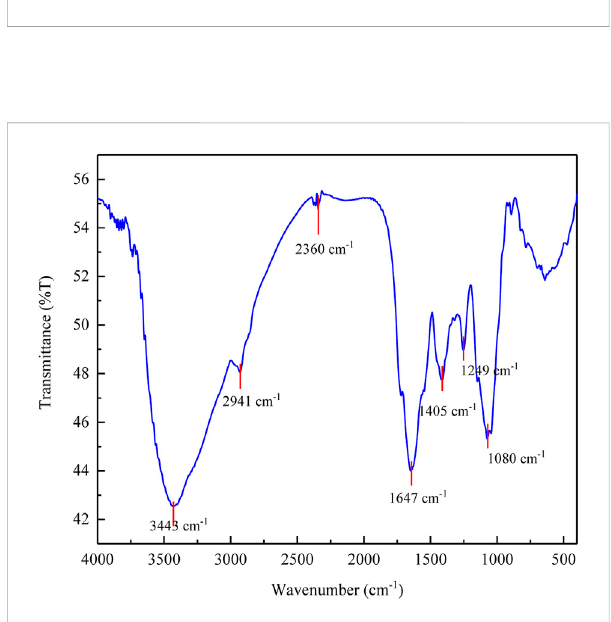
FIGURE 17 FTIR spectra of okra mucilage powder extract.